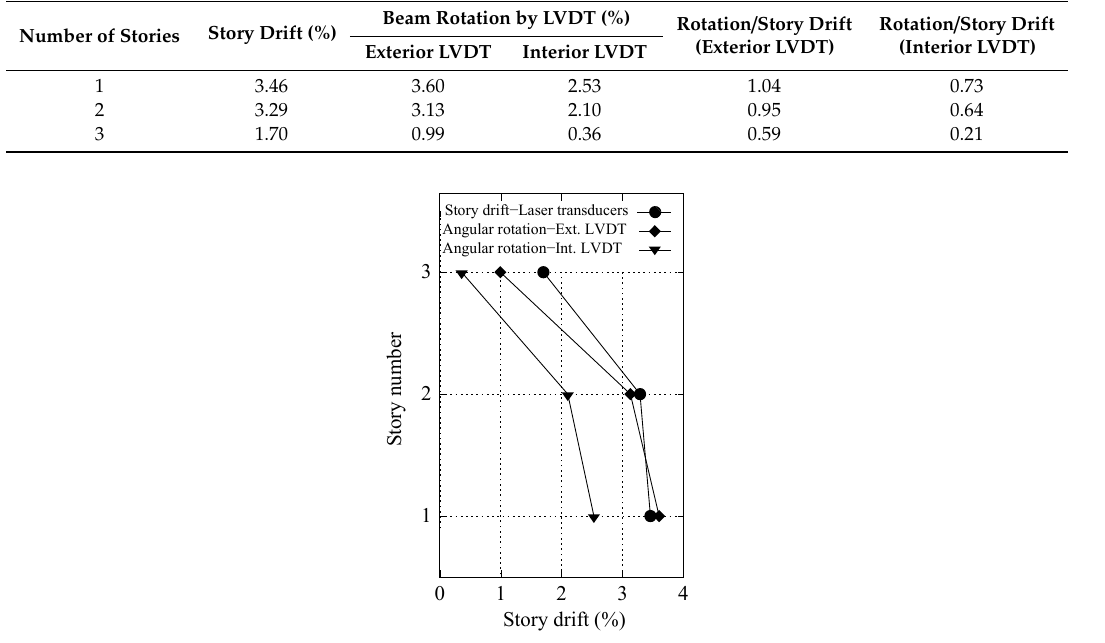
Table 7. Story drift and angular rotation of the hanging walls.